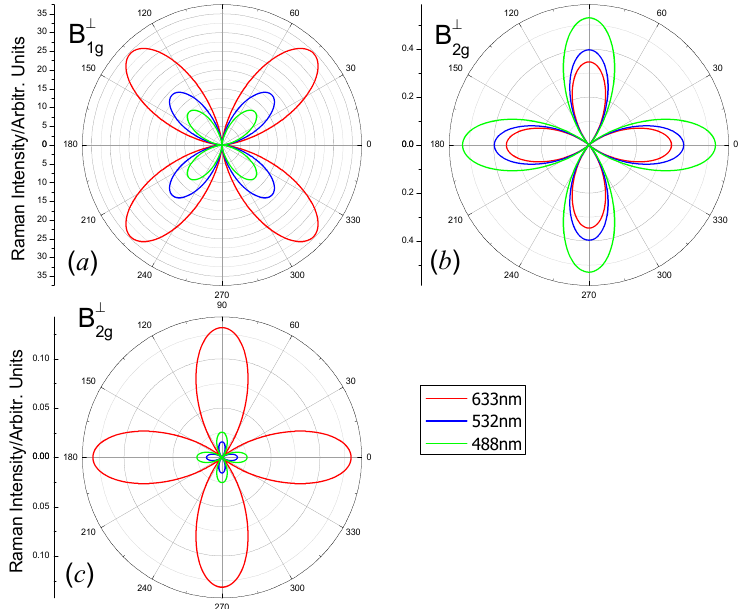
Figure 5. Polar plots of the angular dependent Raman intensities (cid:3627)𝑒⃑ (cid:3046) ∙ 𝑅⃡∙ 𝑒⃑ (cid:3036) (cid:3627) cm − 1 , ( b ) B 2g ‐ 1605 cm − 1 and ( c ) B 2g ‐ 1186 cm − 1 modes of the octagon ‐ structure carbon monolayer excited by laser lines 488 nm (green), 532 nm (blue) and 633 nm (red). The polarization direction of the scattered light is perpendicular to the polarization direction of the incident light. The incident and scattered light wave vectors are in the z